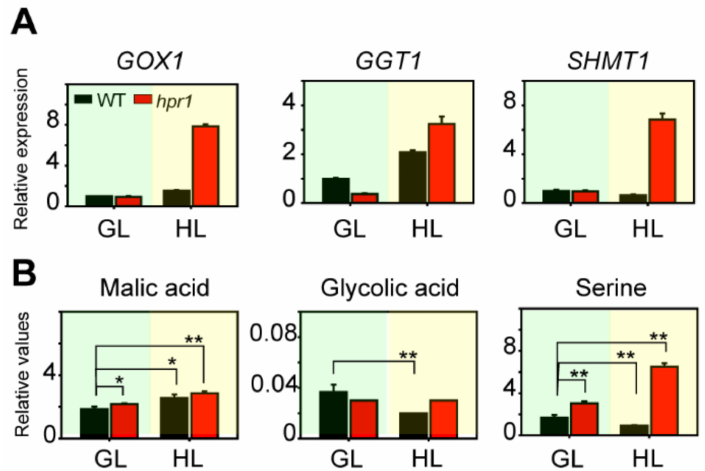
Figure 6. Detection of photorespiratory enzymes and intermediates. ( A ) Expression of photorespira- tory enzymes genes in WT and hpr1 mutants cultivated under growth light (GL, 80 µ mol · m − 2 · s − 1 ) and high light (HL, 350 µ mol · m − 2 · s − 1 ). GOX1 , glycolate oxidase 1; GGT1 , glutamic acid glyox- alate aminotransferase 1; SHMT1 , serine hydroxymethyltransferase 1. Data shown are means ± SD, n = 3, with three independent replicates. ( B ) Selected photorespiratory intermediates in WT and hpr1 mutants. Plants were grown in growth light (GL, 80 µ mol · m − 2 · s − 1 ) and high light (HL, 350 µ mol · m − 2 · s − 1 ) with a 16/8 h day/night cycle, and then leaf materials were harvested. Se- lected metabolites were quantified by GC–MS analysis. Data shown are means ± SD, n = 3, with three independent replicates. Asterisks show significant differences compared to WT under growth light: * p < 0.05; ** p < 0.01 (Student’s t